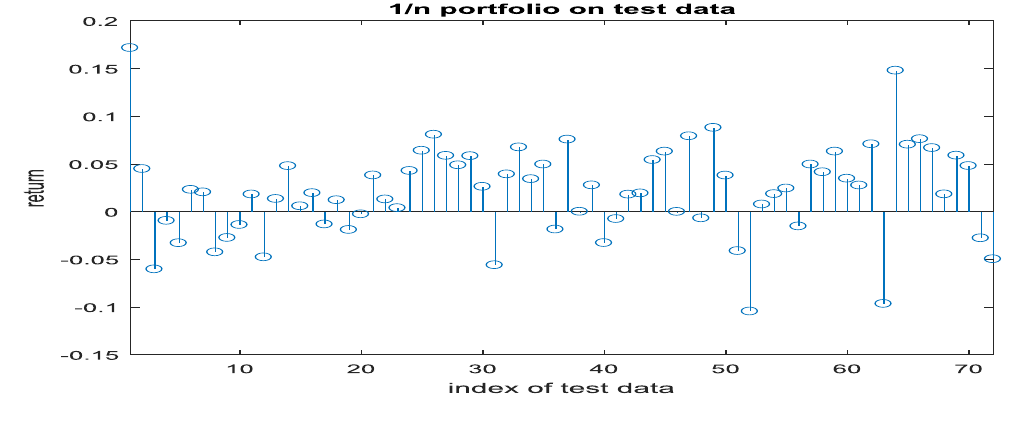
Figure 2. Return of weight parity portfolio on test data